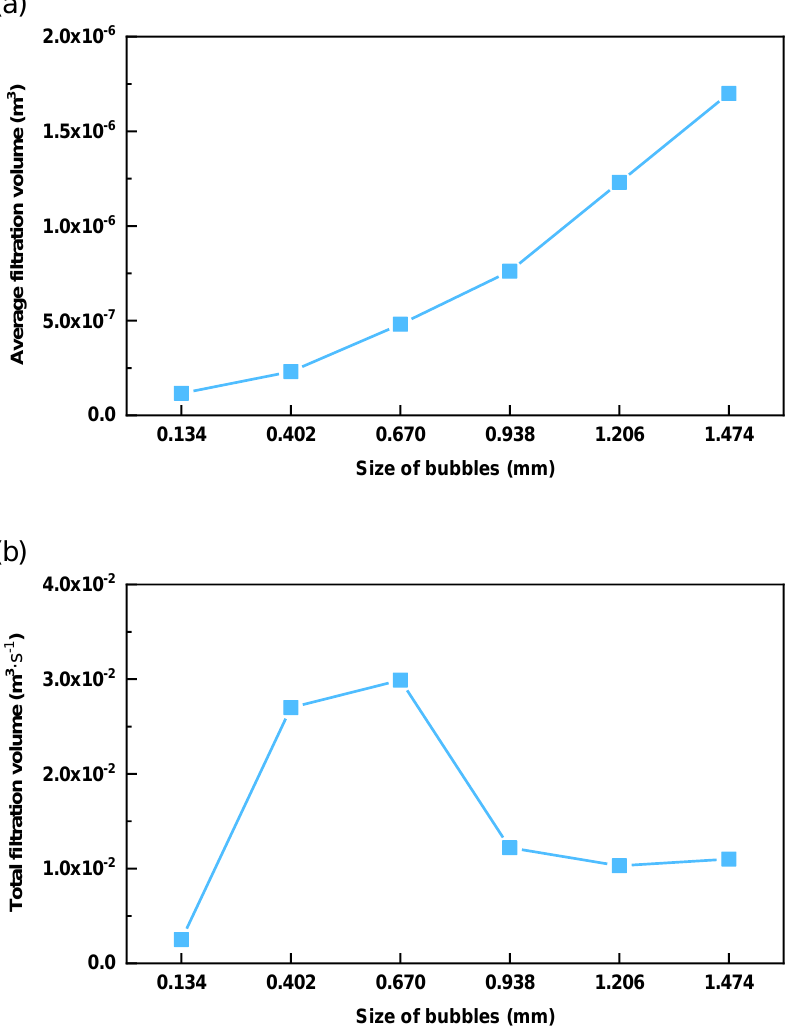
Figure 14. ( a ) Average filtration volume and ( b ) filtration rate of bubbles at different sizes. Finely dispersed bubbles can collide with inclusions in liquid steel of the tundish and promote inclusions to float up and be removed by the top slag. Figure 15 shows the SEM images and EDS results of inclusions adhering to bubbles. The types of inclusions mainly included Al 2 O 3 , Al 2 O 3 -CaO-SiO 2 , and Al 2 O 3 -CaO-SiO 2 -MgO. Most of the bubbles had one inclusion on their surface, but it was also found that a small proportion of bubbles could absorb several inclusions. The statistics results showed that bubbles were more likely to absorb Al 2 O 3 inclusions due to the large wetting angle between